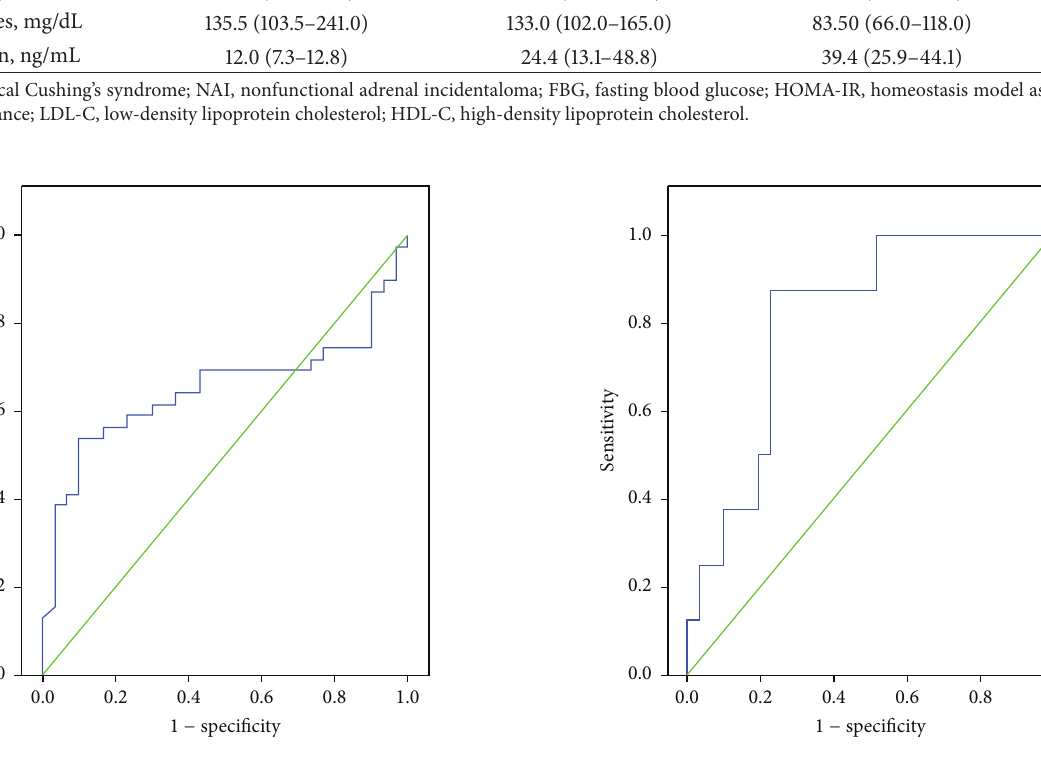
Figure 3: Receiver operating characteristics (ROC) curve for adiponectin level in predicting the presence of subclinical Cushing’s syndrome